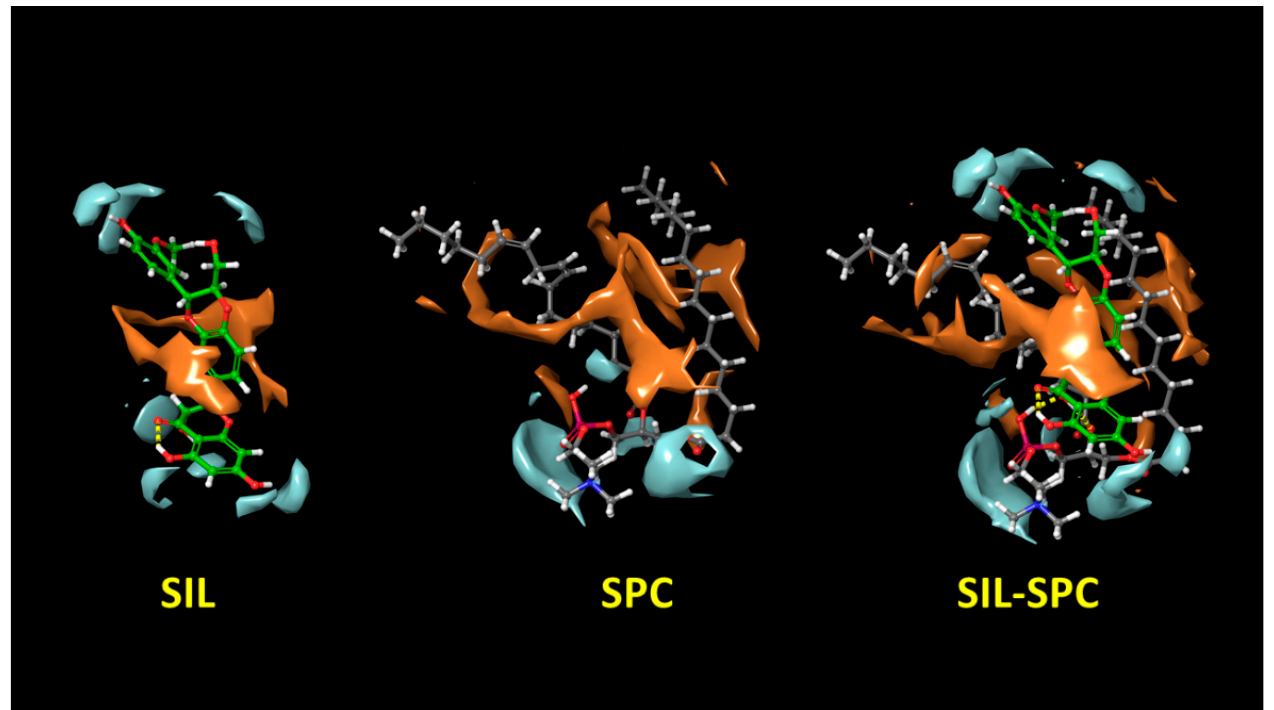
Figure 10. Hydrophilic (blue) and hydrophobic surface (brown) of SIL, SPC and SIL–SPC com- plexes. Table 5. ‘ Δ G bind’ energy for the SIL–SPC complex, determined by Prime MM-GBSA calculations for molecular docking and MD simulation.